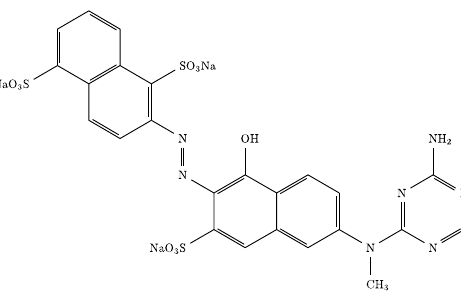
Figure 8. Chemical structure CAS No. 12225-85-3.